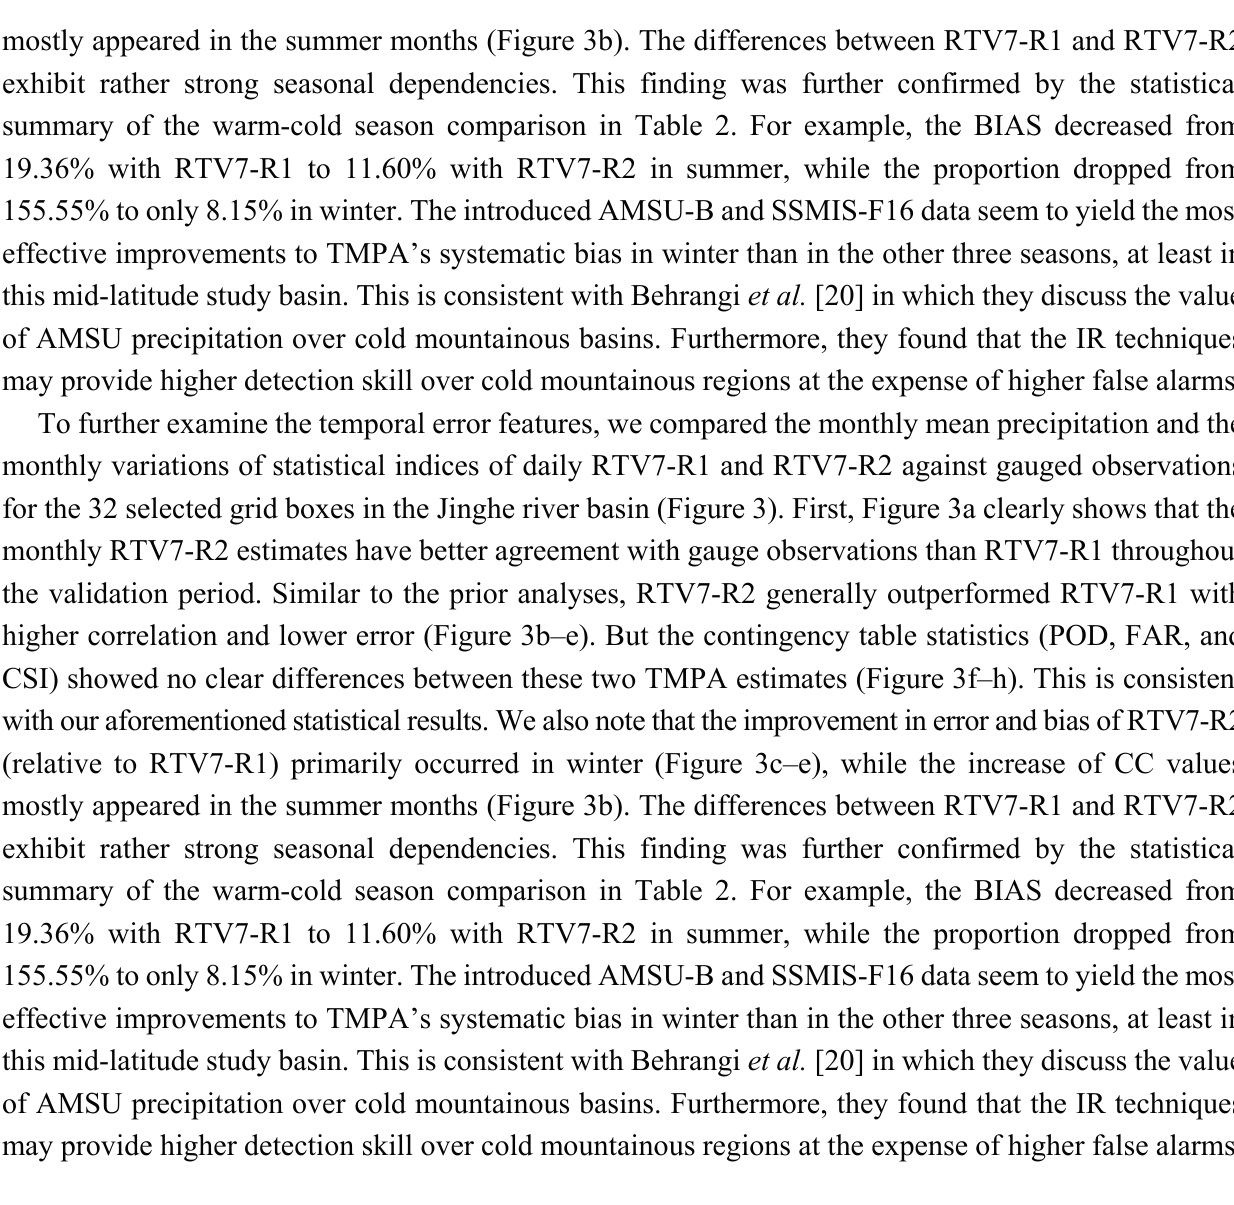
Table 2. Statistical indices (CC, RMSE, ME, BIAS, POD, FAR, and CSI) of daily RTV7-R1 and RTV7-R2 versus gauge for 32 selected gridboxes over the Jinghe river basin in summer (June–August (JJA)) and winter (December–February (DJF)),